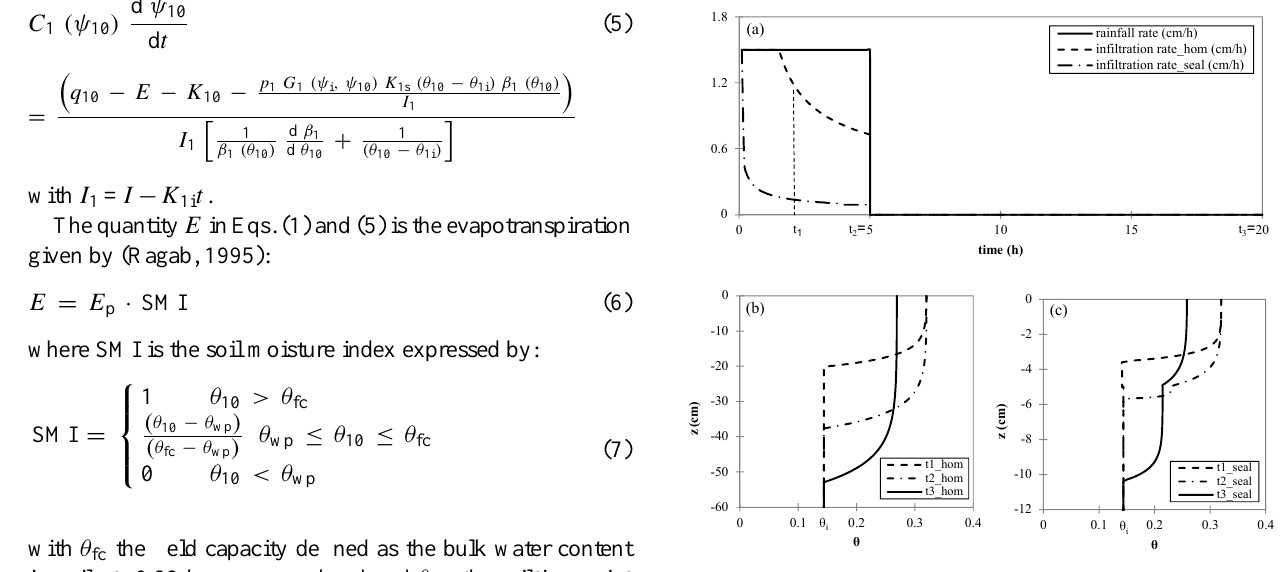
Fig. 1. (a) Time evolution of infiltration rate for homogeneous and sealed soils. (b) and (c) Vertical profiles of soil moisture at the different times indicated in the upper diagram, for homogeneous and sealed soils, respectively.